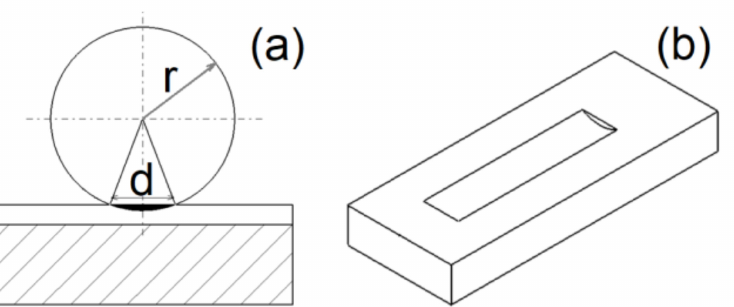
Figure 8. The wear scar generated by reciprocating sliding motion of the ball on a flat specimen; ( a ) 2D view of the wear scar [67] ( b ) 3D view of the wear scar [62].